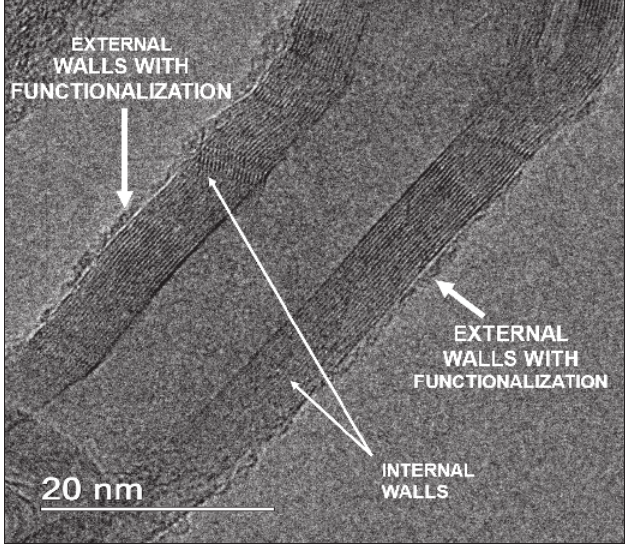
Transmission electron microscopy image of CNT grown directly on the cement